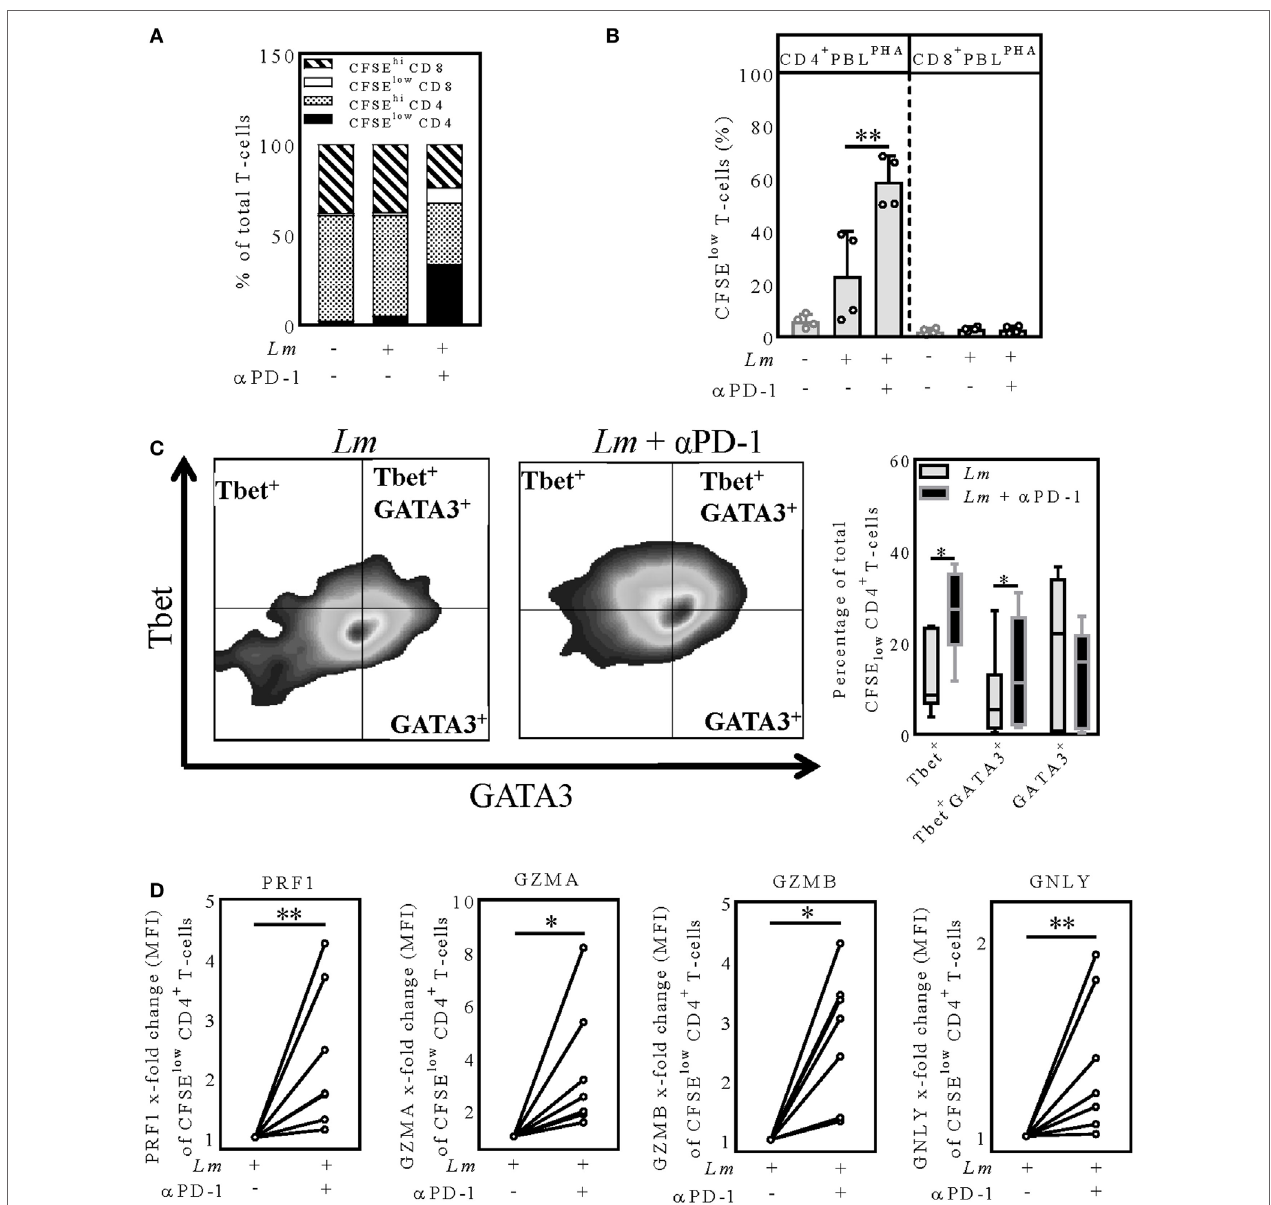
FigUre 4 | PD-1 blockade shifts proliferating CD4 + -T-cells toward a T H 1 or T H 1/T H 2 phenotype and increases expression of cytolytic effector molecules (a,c,D) CFSE-labeled autologous PBLs PHA were cocultivated with Lm -infected hMDDC (MOI = 10) and nivolumab ( α PD-1). After 5 days, cells were harvested, immunostained (a) (CD3, CD4, CD8) (c,D) (CD3, CD4, PRF1, GZMA, GZMB, GNLY, Tbet, GATA3) and analyzed by flow cytometry. T-cells were gated via their FSC/ SSC properties and the labeled antibodies. Data are presented as (a) percentage of total T-cells, (B,c) mean ± SD percentage or (D) mean ± SD x -fold change (MFI) relative to the untreated infected sample. At least two independent experiments were performed ( N = 4–8). (B) CFSE-labeled autologous CD4 + or CD8 + PBLs PHA were cocultivated with Lm -infected hMDDC and nivolumab ( α PD-1). After 5 days, cells were harvested and analyzed by flow cytometry. T-cells were gated via their FSC/SSC properties and CD3. At least two independent experiments were performed ( N = 4). Statistics were calculated (B) using the parametric paired t -test or (c,D) the Wilcoxon matched-pairs signed rank test; P < 0.05 is considered statistically significant (* P < 0.05; ** P < 0.01). hMDDC, human monocyte- derived dendritic cells; Lm , Leishmania major ; PHA, phytohemagglutinin; PBL, peripheral blood lymphocytes; PRF1, perforin; GZMA, granzyme A; GZMB, granzyme B; GNLY, granulysin; Tbet, T-box transcription factor; GATA3, GATA-binding protein 3; CFSE, 5(6)-carboxyfluorescein diacetate N-succinimidyl ester; MFI, mean fluorescence